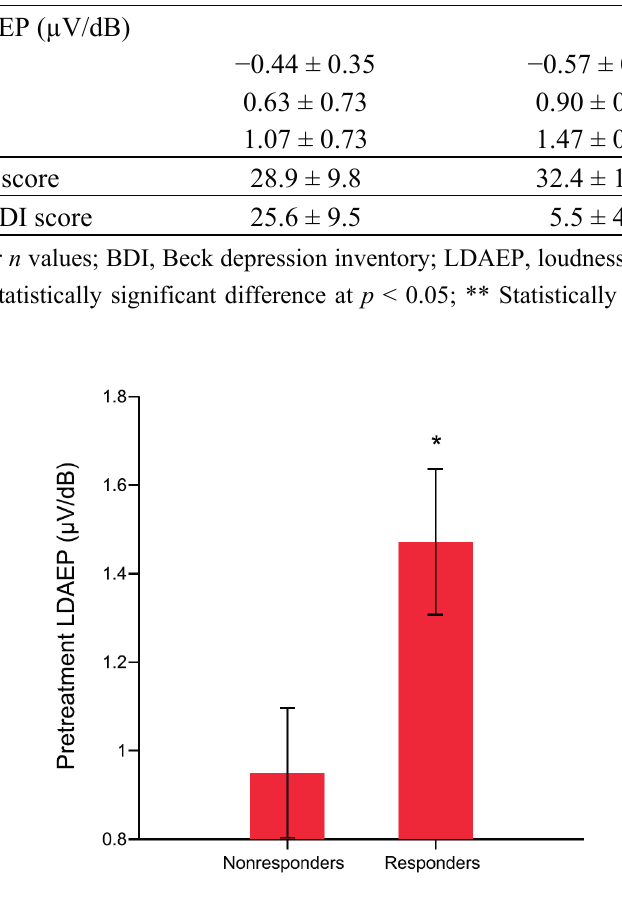
Figure 1. The pretreatment N1/P2 loudness dependence of auditory evoked potentials (LDAEP) of responders and nonresponders (responders were defined as those with a reduction in the Beck Depression Inventory (BDI) score of >50% between baseline and follow-up) among major depressive disorder (MDD) patients ( t = − 2.176, p = 0.036). The data are presented as mean and standard error values. * Statistically significant difference at p <